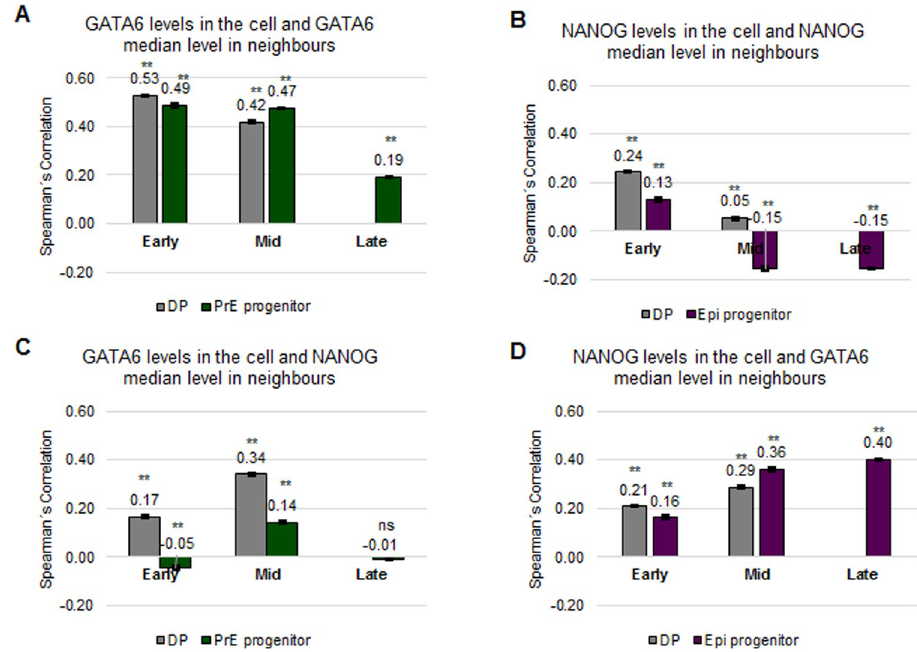
Fig 5. DP as well as PrE progenitor cells in early and blastocysts cluster together according to their GATA6 levels (data II). (A) Spearman’s correlation coefficients of GATA6 levels of a cell and the median GATA6 levels of its neighbours in the indicated populations in the ICM and embryonic developmental stages (). �� : p < 0.01 Mann- Whitney test with Bonferroni correction for comparison with the null model. The error bars represent the standard errors calculated by bootstrap sampling the experimental data 100 times, here and in B, C and D. See S1 Text for further details. (B) Spearman’s correlation coefficients of NANOG levels of a cell and the median NANOG levels of its neighbours in the indicated populations in the ICM and embryonic developmental stages. (C) Spearman’s correlation coefficients of GATA6 levels of a cell and the median NANOG levels of its neighbours in the indicated populations in the ICM and developmental stages. (D) Spearman’s correlation coefficients of NANOG levels of a cell and the median GATA6 levels of its neighbours in the indicated populations in the ICM and embryonic developmental stages. Details on the number of embryos and cells analysed are in S1 and S2